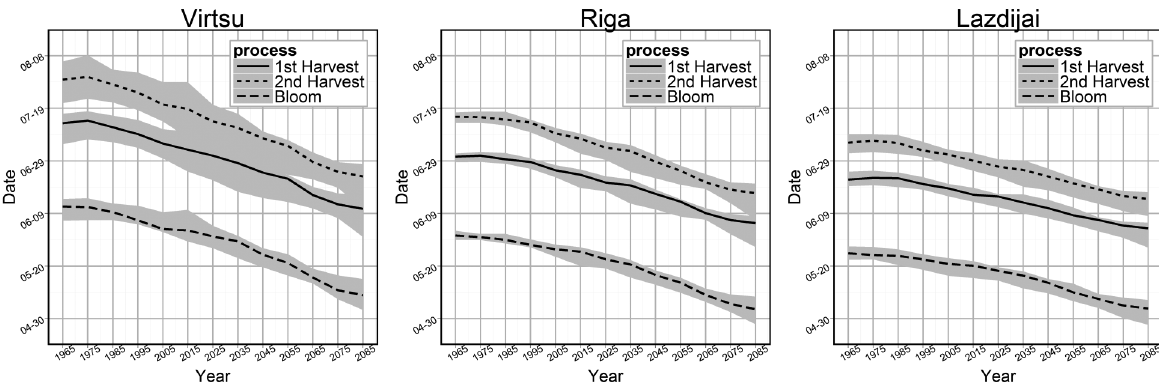
Fig. 9. Ensemble spread in the timing of strawberry phenological processes; lines show median values and grey areas show the interval between the 20th and 80th